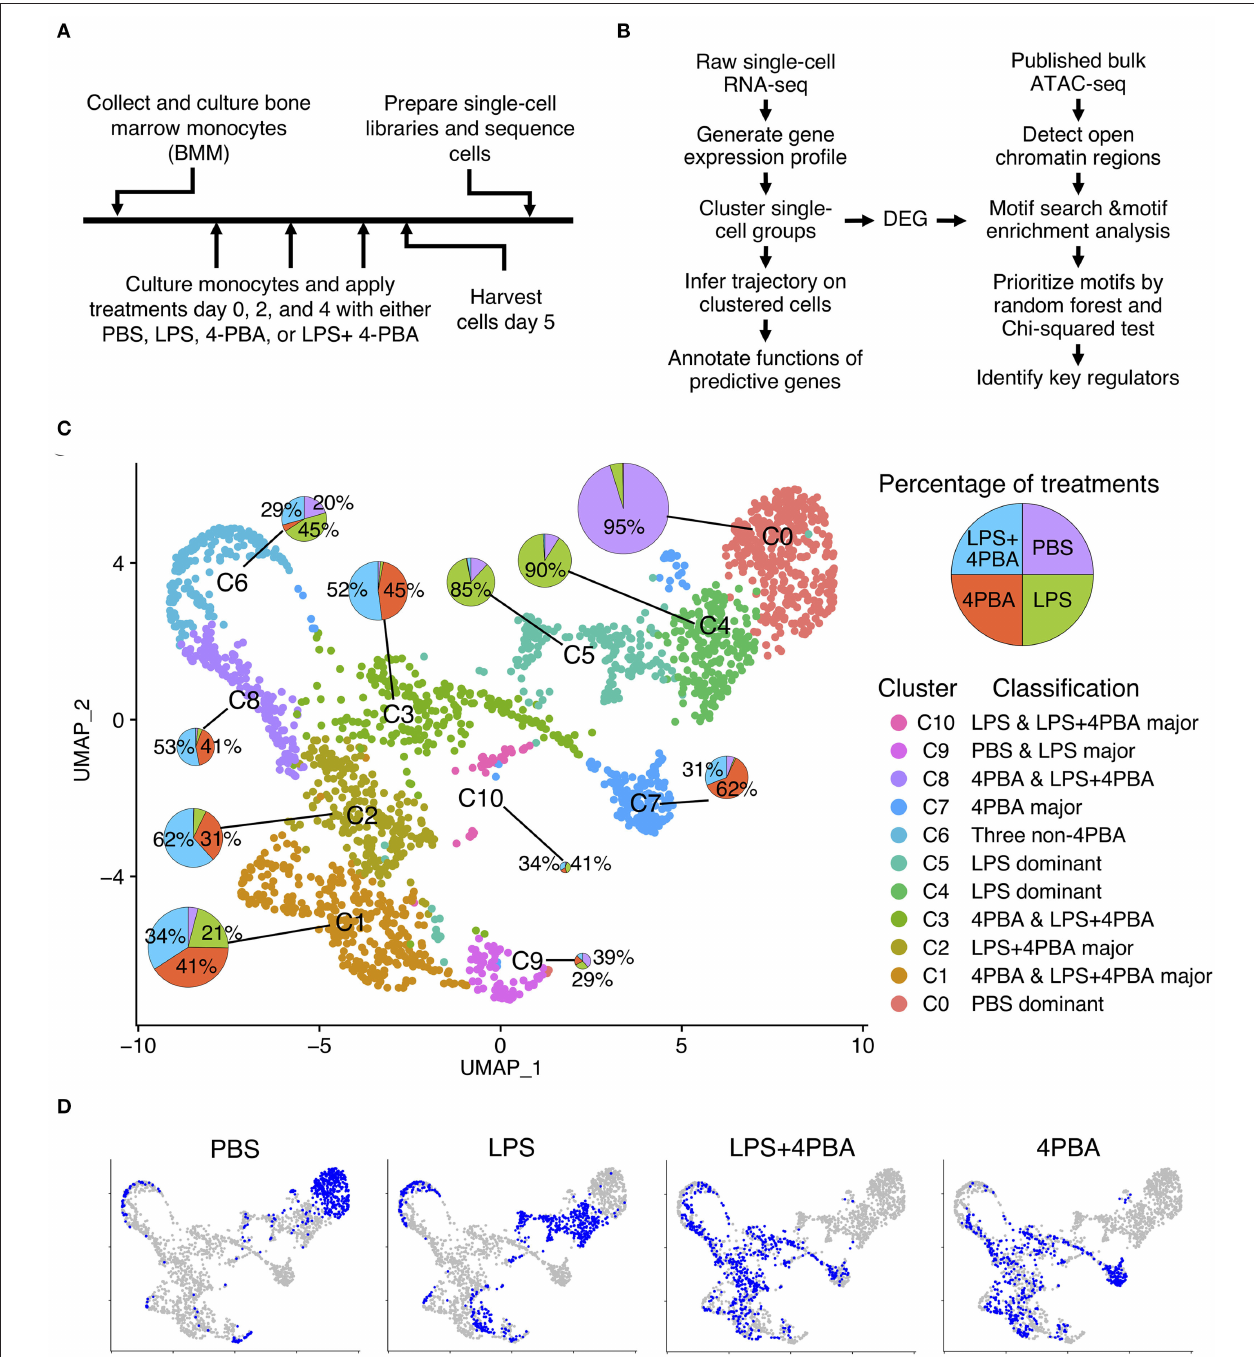
FIGURE 1 | Single cell analysis of LPS and 4PBA treated monocytes. (A) Experimental design and data collection. (B) Data analysis pipeline. (C) Clustered cell groups. Dimension reduction using UMAP shows the diversity of cell populations in response to treatments. A pie chart denotes portions of treatments in a cluster. Sizes of the pie charts are correlated with the number of cells in each cluster. (D) Distribution of cells from each treatment or control samples. Total cells in a background are in grey color and cells in a sample are in blue color.